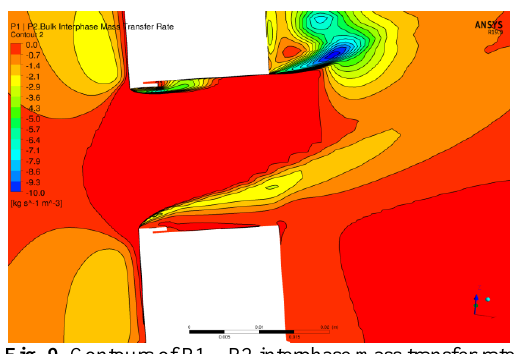
Fig. 9. Contours of P1 – P2 interphase mass transfer rate